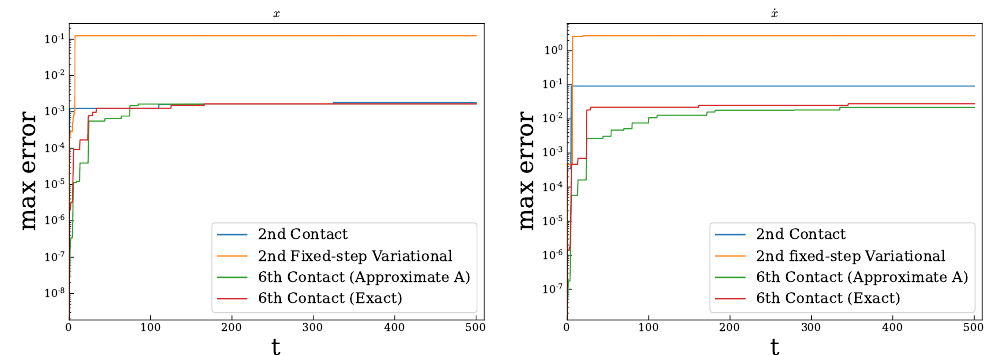
Figure 12. Maximum absolute errors in x and ˙ x up to a given time for the reference contact integrators compared to the LSODA method along the orbit in Figure